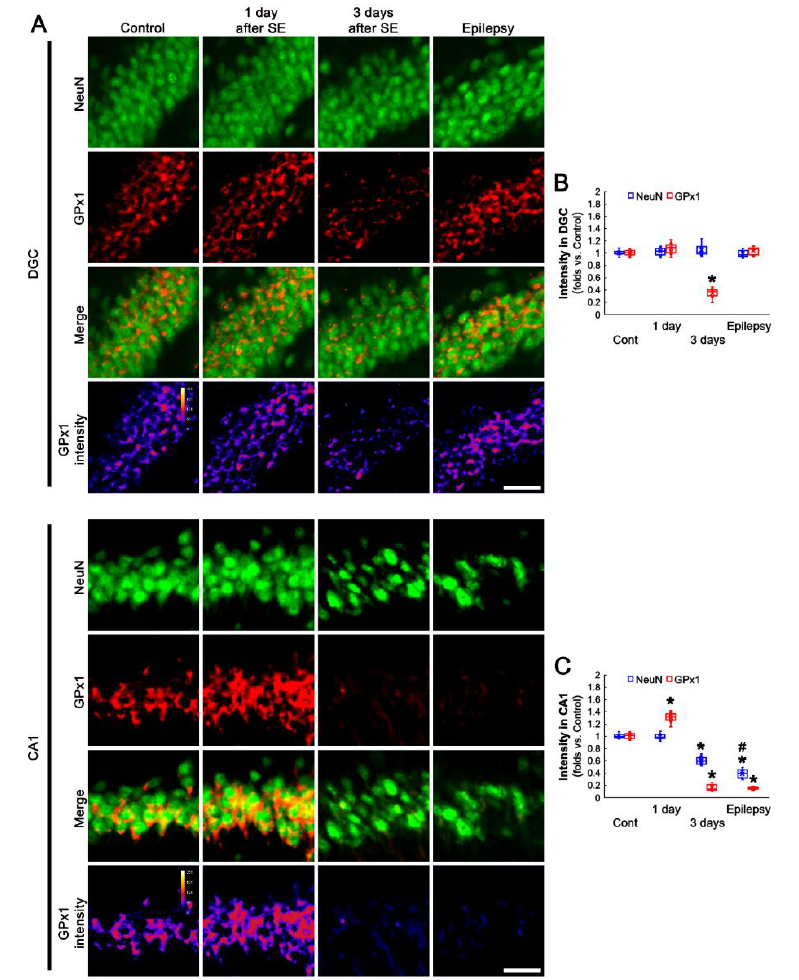
Figure 2. Neuronal GPx1 expression in dentate granule cells (DGC) and CA1 neurons following SE. In DGC, GPx1 expression is transiently reduced at 3 days after SE. In CA1 neurons, however, GPx1 expression is temporally increased at 1 day after SE, and gradually reduced, accompanied by neuronal loss. ( A ) Representative photos of GPx1 expression and its intensity. Bar = 25 μm. ( B , C ) Quantification of GPx1 intensity in DGC ( B ) and CA1 neurons ( C ) (*, # p < 0.05 vs. control and 3 day-post SE animals, n = 7, respectively).